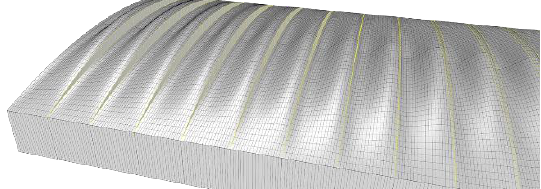
Figure 18: The Parametric Modeling allowed for the identification of the precise geometry of the interstice between the modules of the Gaussian Roofs, where the openings are